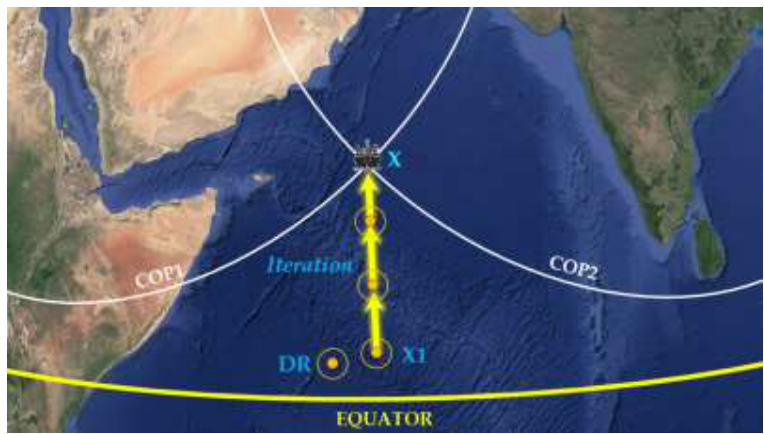
Figure 4. The iteration procedure of Newton’s method.